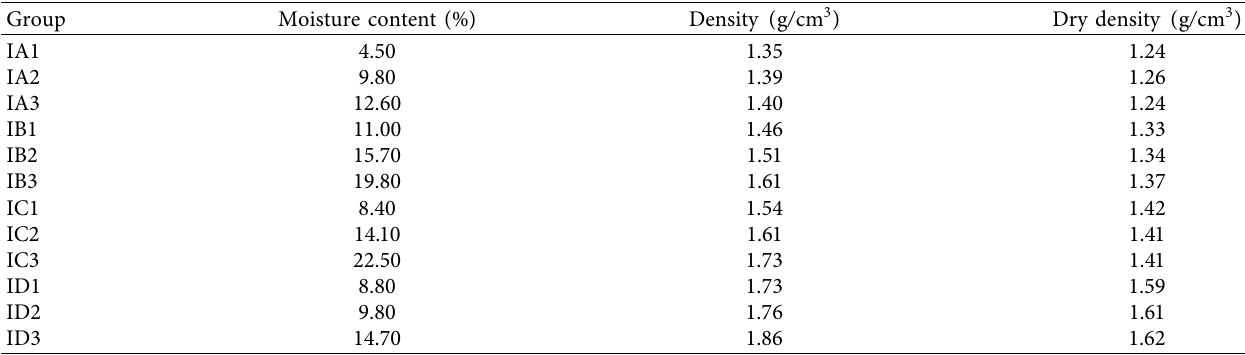
Table 1: Intact loess sample